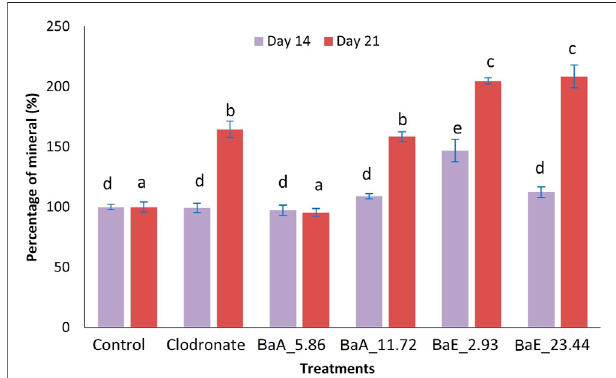
FIGURE 9 | Percentage of mineral in B. acmella aqueous ( Ba A) and ethanol ( Ba E) extracts. Control (untreated cells), Positive control (Clodronate), BaE_2.93 ( Ba E 2.93 µg/ml), BaE_23.44 ( Ba E 23.44 µg/ml), BaA_5.86 ( Ba A 5.86 µg/ml) and BaA_11.72 ( Ba A11.72 µg/ml)differentalphabets show signi fi cantdifferent ( p < 0.05) between treatmentsin asameday. Thedata are presented as mean ± SEM ( n (cid:2) 6).